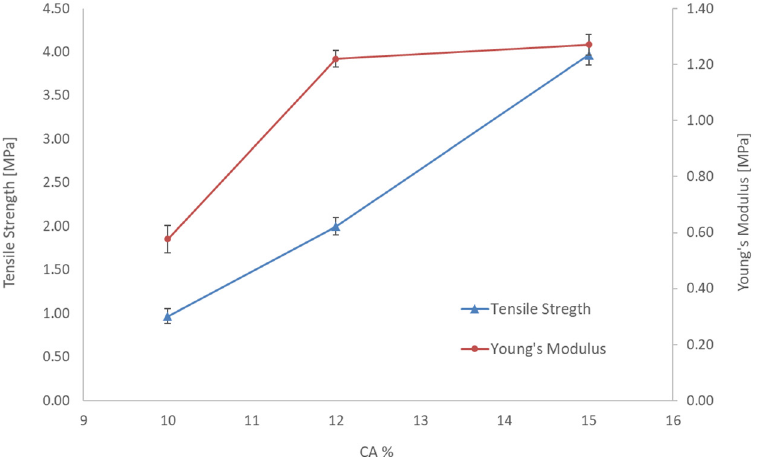
Figure 5. Tensile strength and Young’s modulus of the CA membranes prepared at different poly- mer concentrations.